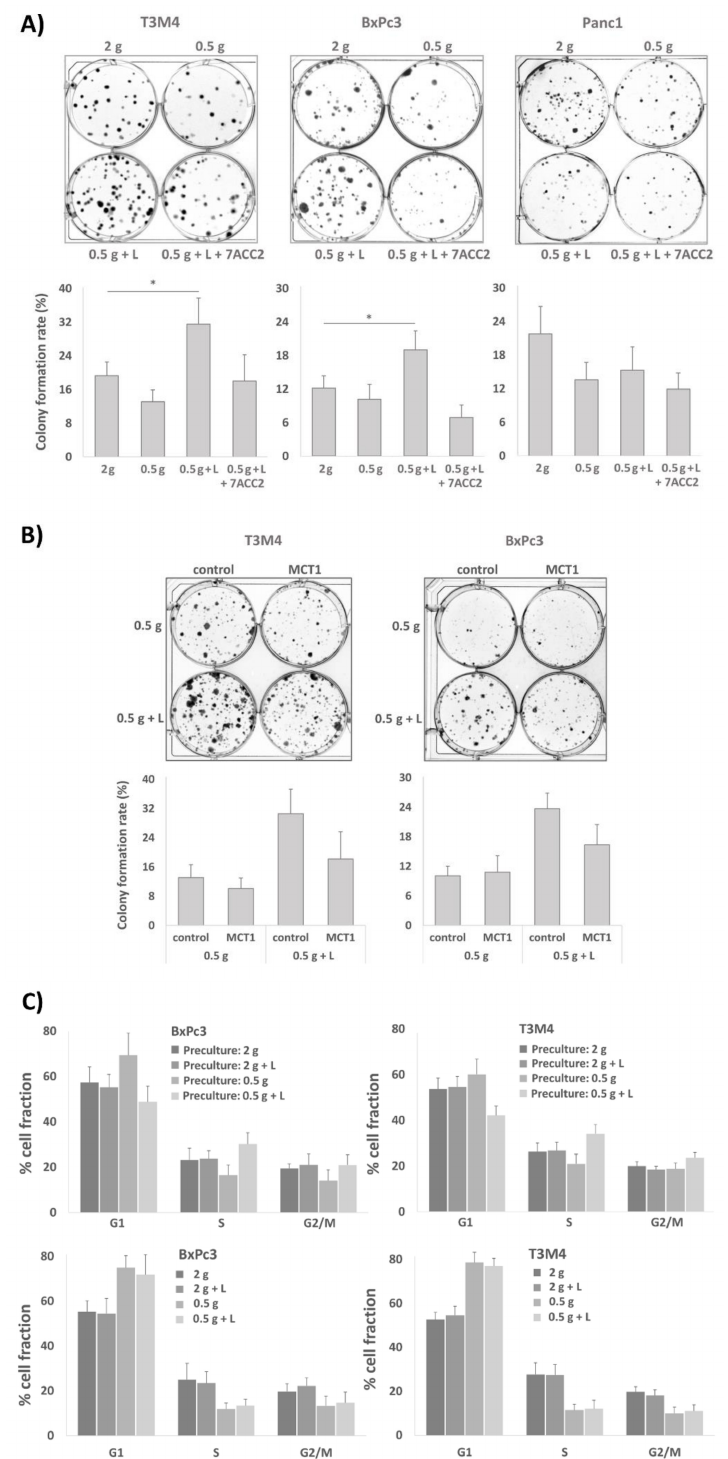
Figure 4. Lactate treatment augments colony formation capacities of T3M4 and BxPc3 cells under glucose restriction. ( A ) BxPc3, T3M4, and Panc1 cells were precultured in normal medium (2 g) or under glucose restriction using medium with 0.5 g / L glucose (0.5 g) for 72 h, either in the absence or presence of 20 mM lactate (0.5 g + L and 2 g + L, respectively) and additionally of 20 µ M 7ACC2. Then, the cells were reseeded at a density of 200 cells / well on six-well plates in normal culture medium.